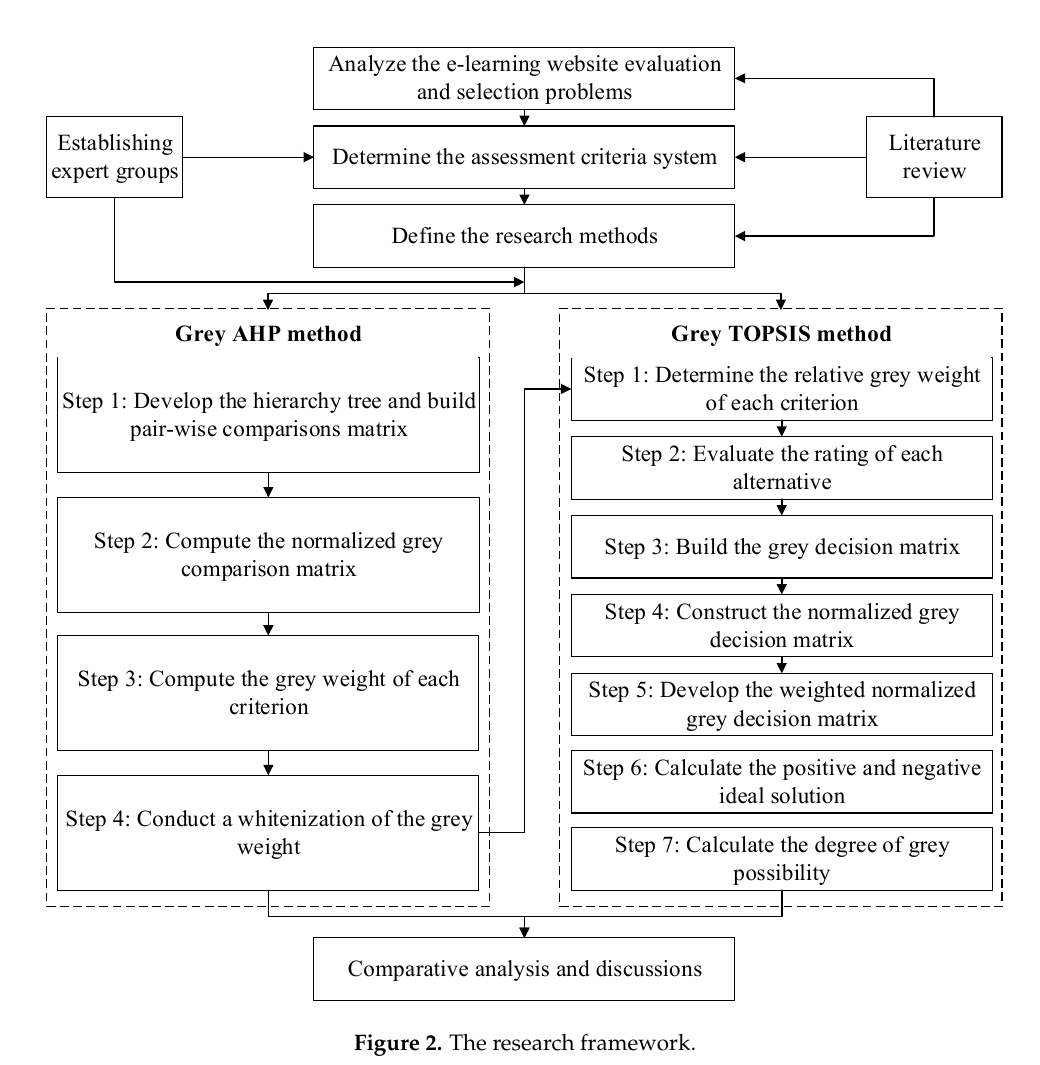
Figure 2. The research framework.